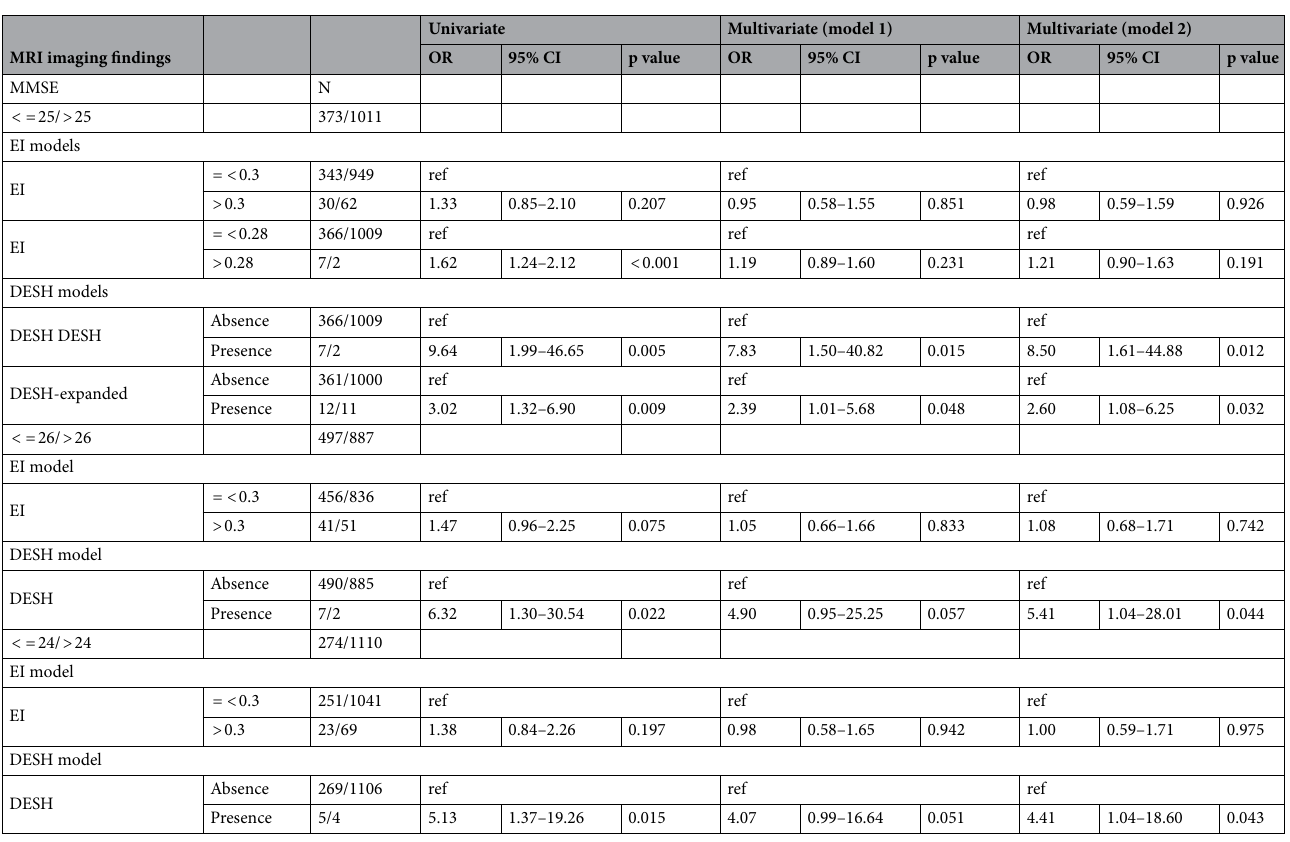
Table 3. Logistic regression analyses of DESH and Evans index for cognitive impairment in the participants who underwent MRI (n = 1384). Multivariate analyses were performed by adjusting for age, sex, BMI and